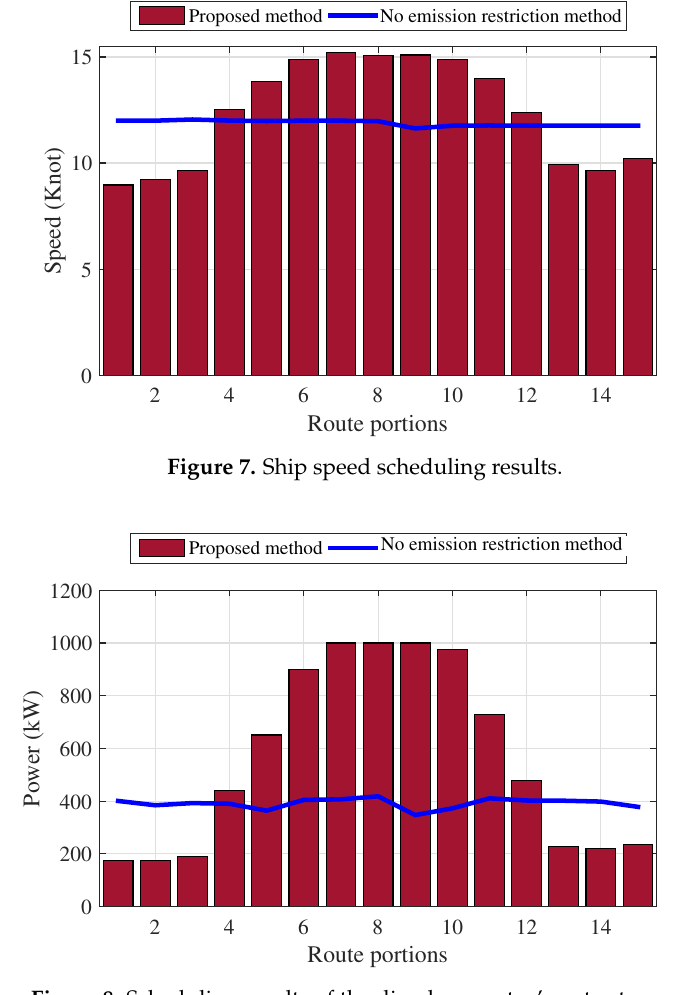
Figure 8. Scheduling results of the diesel generator’s output power.